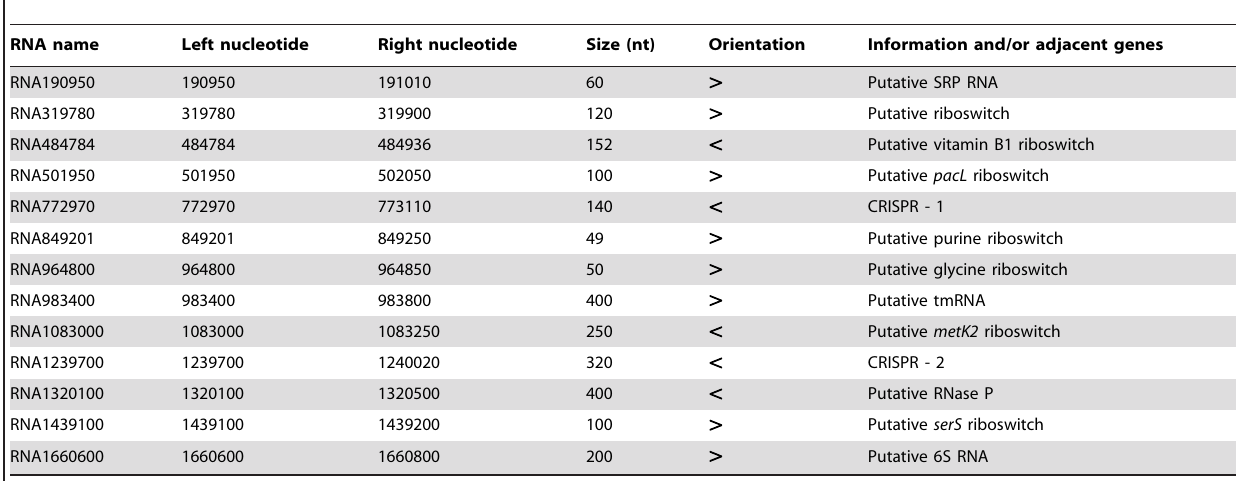
Table 2. Candidate riboswitches and other small RNAs identified by bioinformatic and tiling microarray approaches.